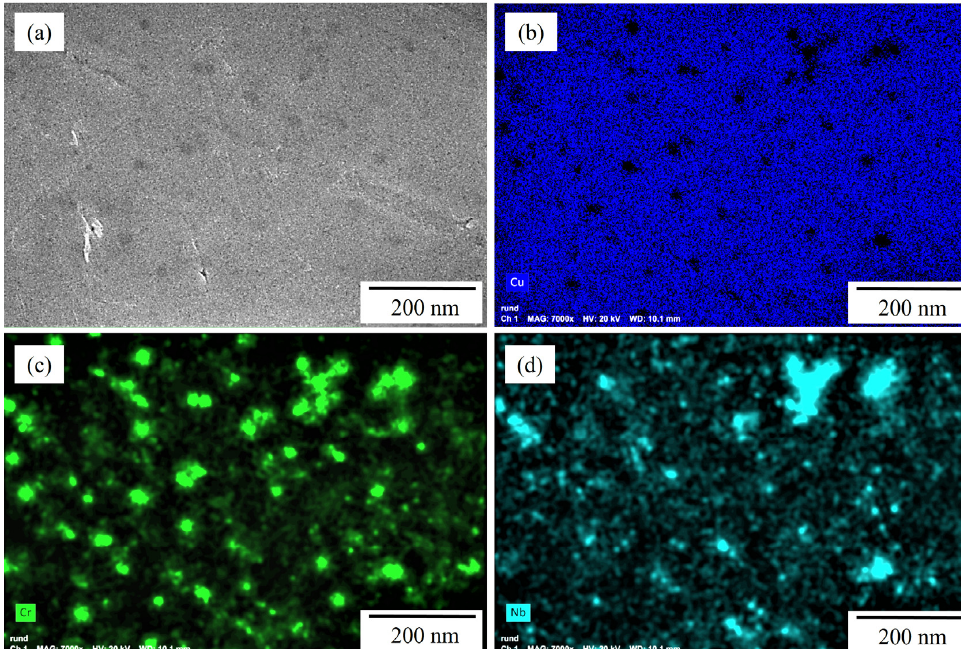
Figure 4. EDS maps of cross sections of randomly selected Cu-3.3Cr-1.5Nb powder particles in gas-atomized state: ( a ) BSE image showing the presence of darker-appearing particles indicating local enrichment of elements with higher atomic number. EDS maps of copper ( b ), chromium ( c ) and niobium ( d ) confirm the local enrichment of chromium and niobium of dark-appearing particles.